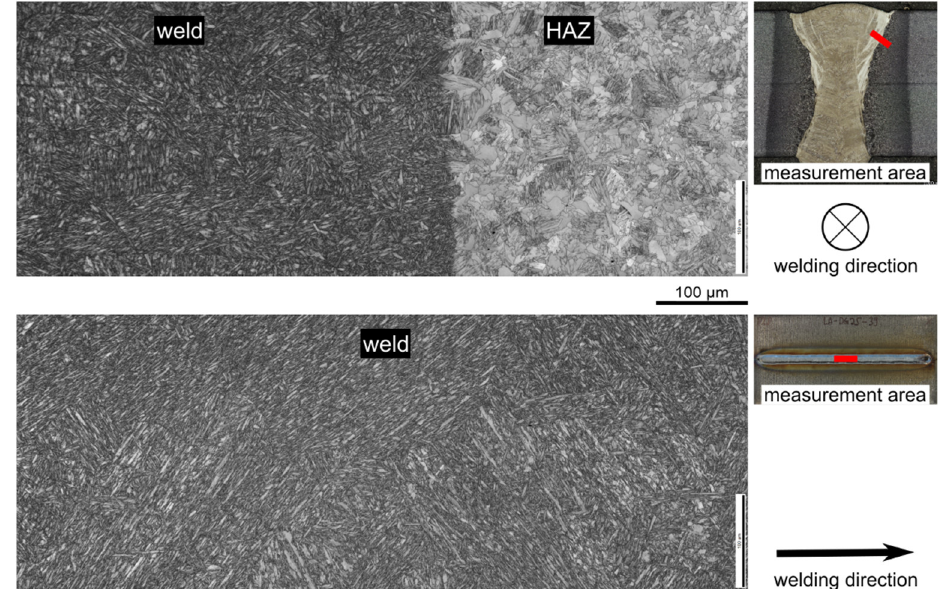
Figure 12. Image-quality (grey) maps of the measured areas.